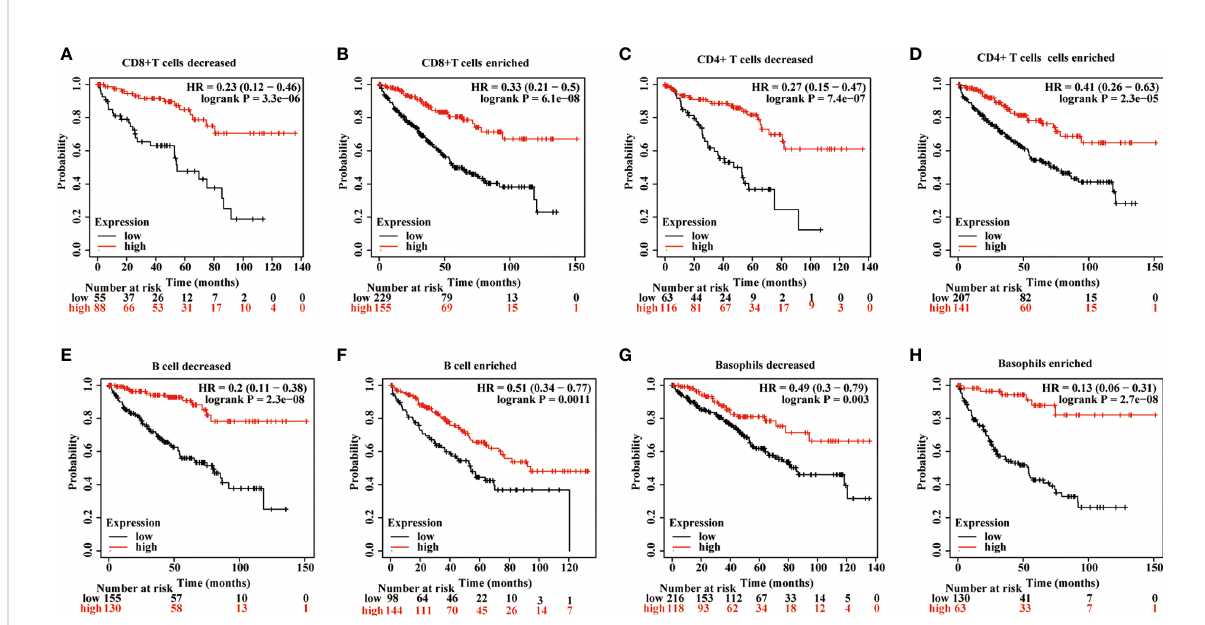
FIGURE 7 The in fl uence of METTL24 expression on the OS of KIRC patients with high or low in fi ltration degrees of immune cells. The impact of METTL24 expression on the OS of KIRC patients with enriched or decreased in fi ltration ratios of (A, B) CD8+ T cells, (C, D) CD4+ memory T cells, (E, F) B cells, (G, H) basophils. The survival analysis was performed on Kaplan-Meier plotter